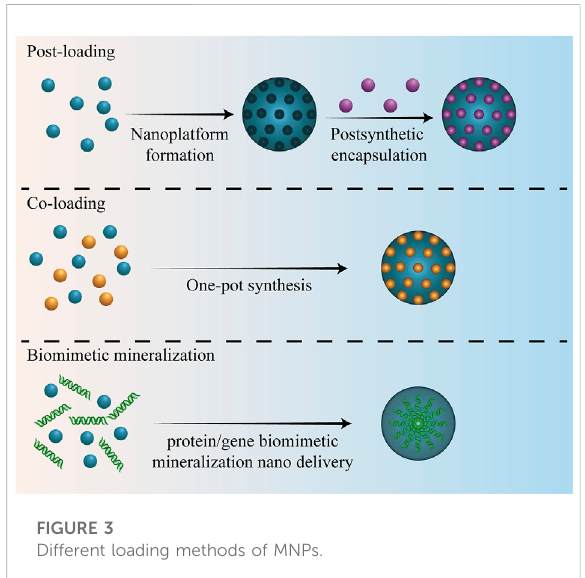
FIGURE 3 Different loading methods of